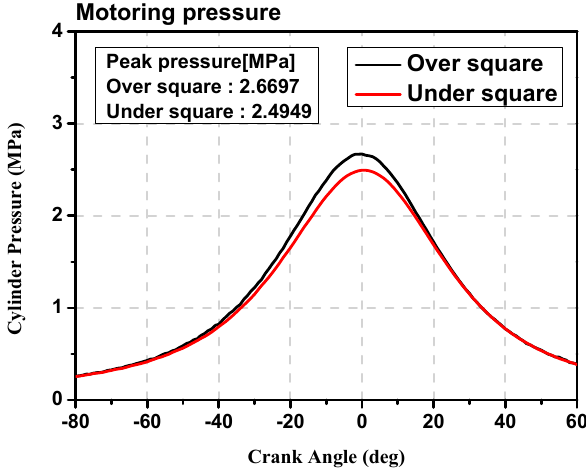
Figure 2. Motoring pressure for over- and under-square engines .